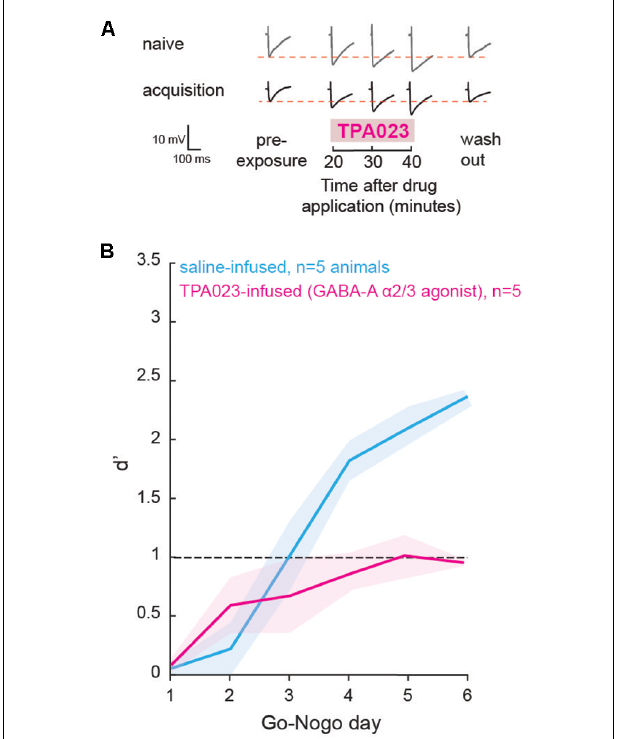
FIGURE 5 | Direct manipulation of inhibition affected learning. (A) Representative traces of maximum evoked IPSPs recorded from striatal cells of the control population during the naïve and acquisition phases, with the addition of a GABAA- α 2/3 subunit receptor agonist (TPA023) to the bath. Pre- and post-exposure traces are shown for comparison. (B) Mean ( ± SEM) d (cid:48) measures of animals which received local infusions of TPA023 (pink) or saline (blue) bilaterally in the auditory striatum prior to each Go-Nogo session. Infusions of TPA023 caused a significant impact on learning as compared to saline